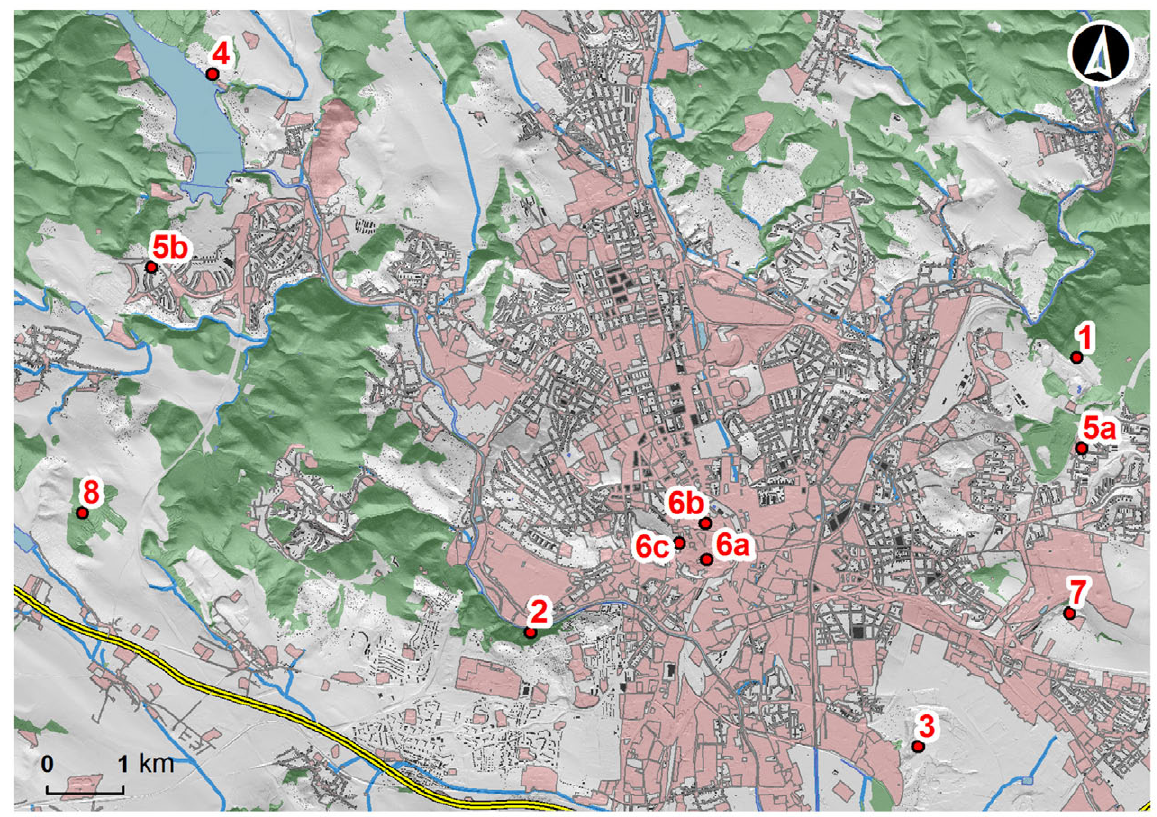
Fig. 2. A sketch of the position of the selected sites within the study